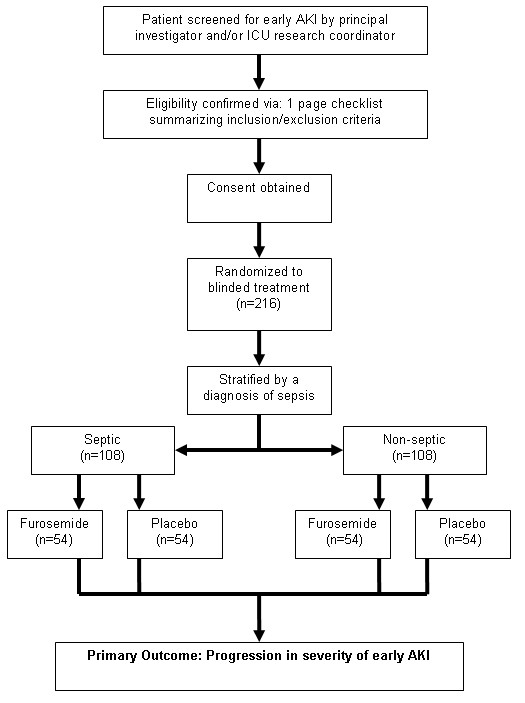
Overview of patient flow.